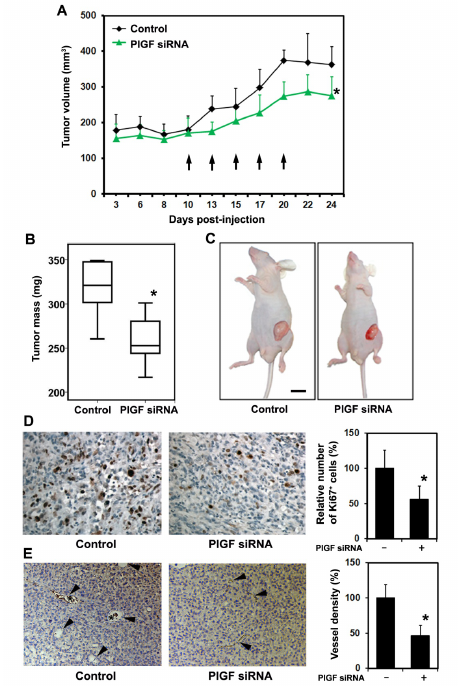
Figure 3. Stromal PlGF blockade reduces growth of prostate cancer xenografts. ( A ) Intratumoral injections of siRNA targeting murine PlGF commencing 10 days following PC-3 engraftment and cycled at the indicated time points (arrows) significantly reduced tumor volumes on day 24. * significantly different from control, p = 0.015; ( B ) Tumor mass was significantly reduced in the PlGF siRNA group on day 24. * significantly different from control, p = 0.008; ( C ) Representative images of tumor-bearing mice on day 24; ( D ) Representative images show that siRNA targeting murine PlGF reduces tumor proliferation (Ki-67 staining). * significantly different from control, p < 0.05; ( E ) Stromal PlGF inhibition reduces microvessel density in the tumors on day 24. Representative images of sections from control tumors and PlGF siRNA treated tumors (arrowheads indicate microvessels; asterisks indicate erythrocytes within vessels) and quantification of microvessel density. Results are expressed as percentage of controls. * significantly different from control, p <